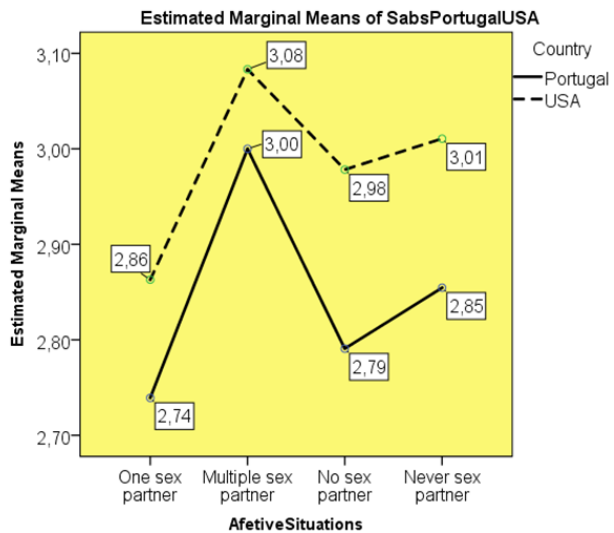
Figure 2. ABS considering students ’ nationality and affective relationship.